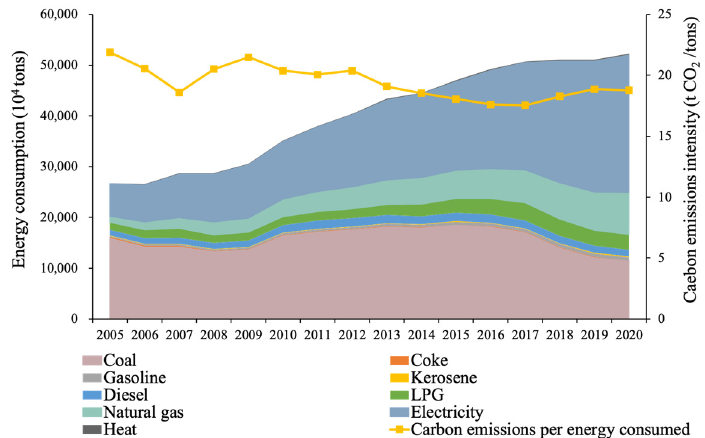
Figure 6. Energy consumption and its carbon emissions intensity in the building sector; the different types of energy consumption are converted to standard coal.